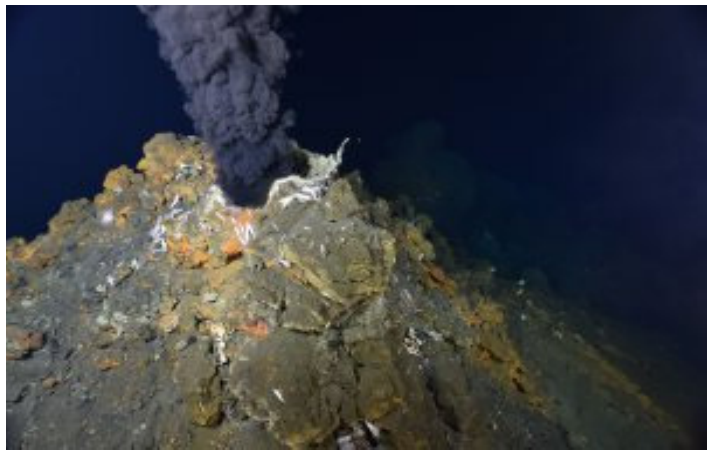
Figure 2. Polymetallic sulfides (Source: ISA).